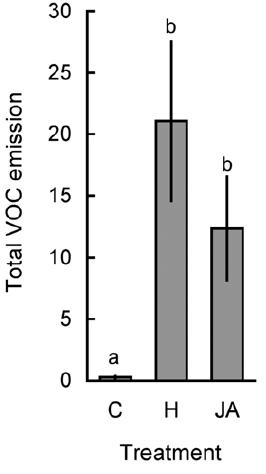
Figure 3. Comparison of the total amount of VOCs emitted from differentially treated lima bean plants. Plants were left undamaged (C), herbivore-damaged (H, Mexican bean beetle ( Epilachna varivestis )), or treated with the phytohormone JA (JA). The total of the following emitted volatiles are given as mean peak area ( 6 95% CI) relative to the peak area of an internal standard per 24 h and per gram dry weight: (3 Z )-hexen-1-yl acetate, ( E , Z )- b -ocimene, ( R )-(-)-linalool, DMNT, C 10 H 14 , methyl salicylate, C 10 H 16 O, ( Z )-jasmone, b -caryophyllene, TMTT. Plants of the herbivore treatment were exposed to five beetles for 24 h, which had consumed 14.2 6 3.5% (mean 6 95% CI) of the plants N total leaf area (5 leaves). Sample sizes were 16, 16, and 6 respectively. Different letters indicate significant differences between treatments ); (Tamhane’s post-hoc test: P ,